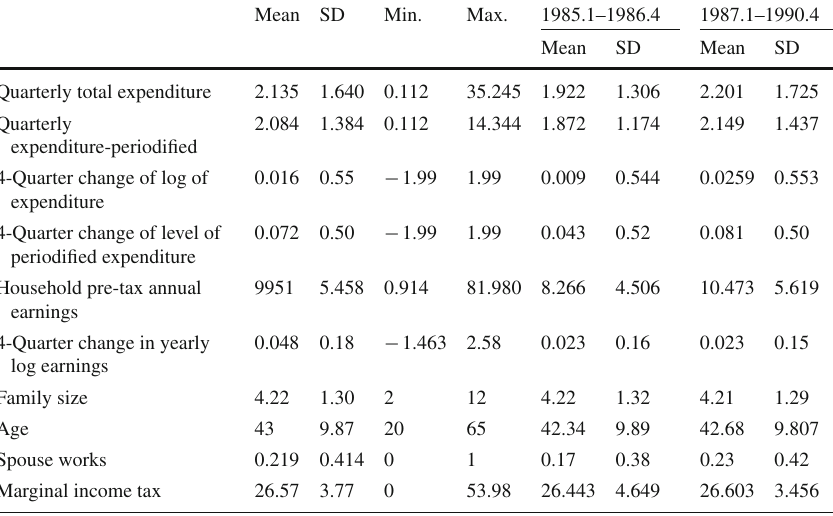
Table 2 Summary statistics, expenditure survey